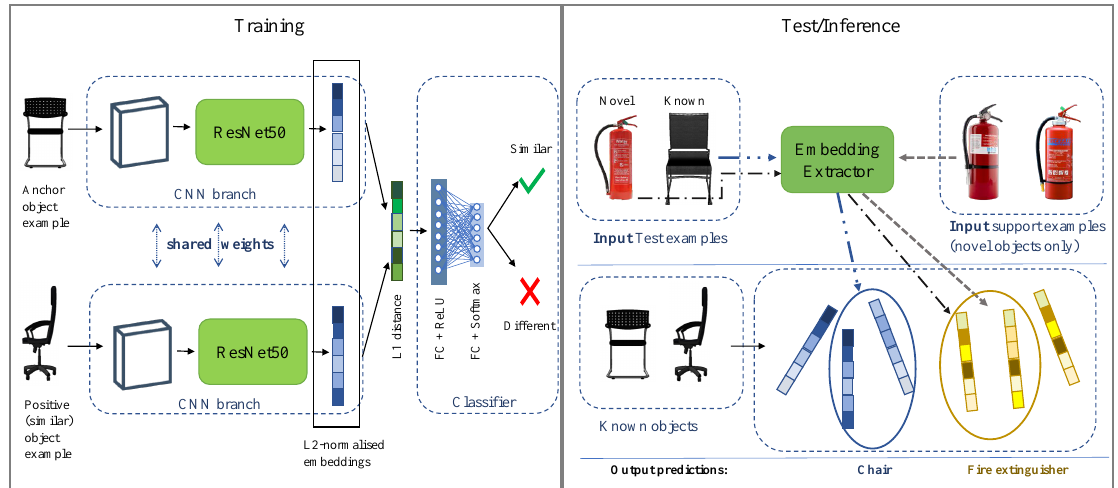
Figure 1. Object Recognition workflow. A Siamese Network comprising two ResNet50 CNN branches is trained on known object classes. The resulting 2048-dimensional feature embeddings are first L2-normalised and then combined through their component-wise L1 distance. The two fully-connected layers operate as a binary classifier to conclude on the similarity of each image pair. At test time, objects are classified based on the L2 nearest neighbour in the obtained feature space, comprising of: (i) the embeddings learned during training and (ii) the embeddings extracted for the input novel support